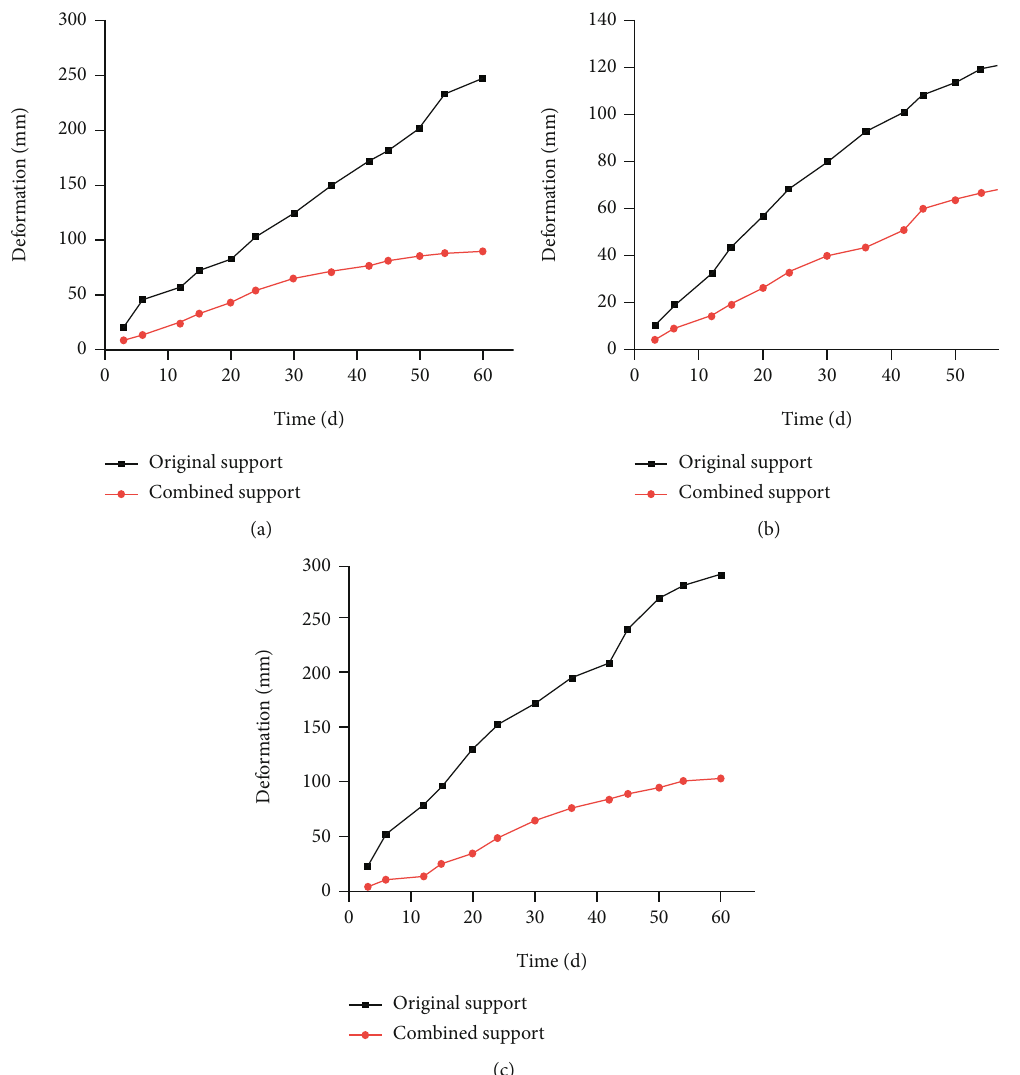
Figure 10: Roadway surface deformation curve. (a) Roof Subsidence. (b) Floor Heave. (c) Right Side O ff